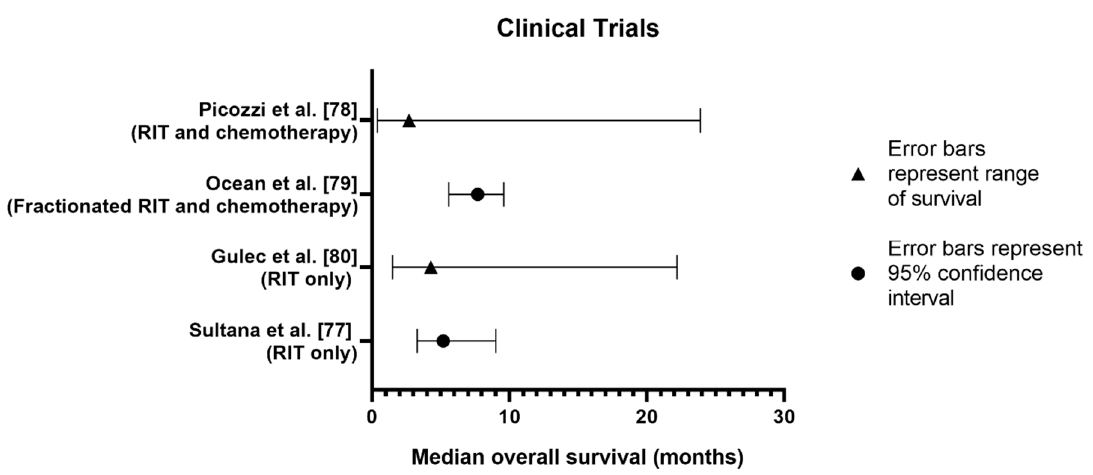
Figure 6. Overall median survival of PDAC patients in β RIT clinical trials.